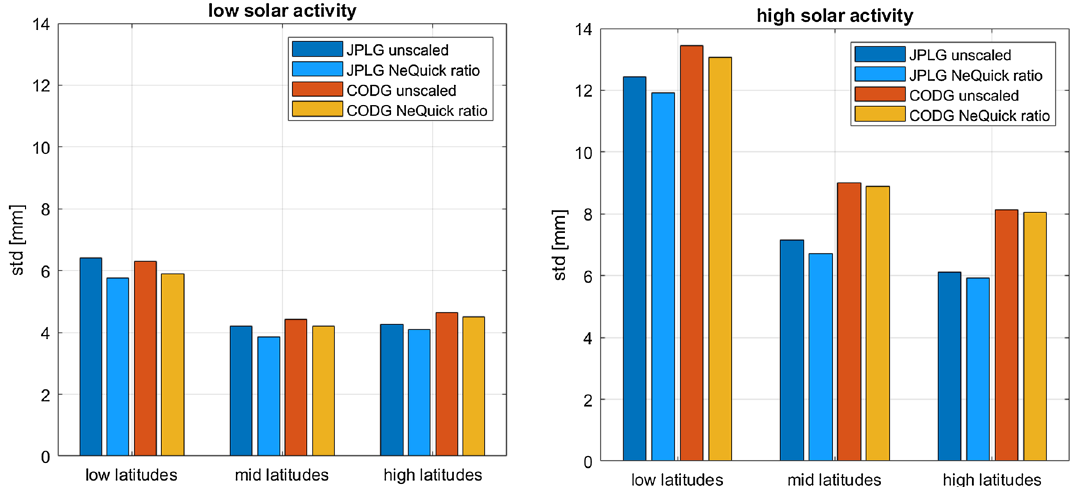
Fig. 7 Standard deviations of the differences of GIM solutions with respect to smoothed dual-frequency altimeter corrections for different solar activities (left: low; right: high) and different geomagnetic latitude